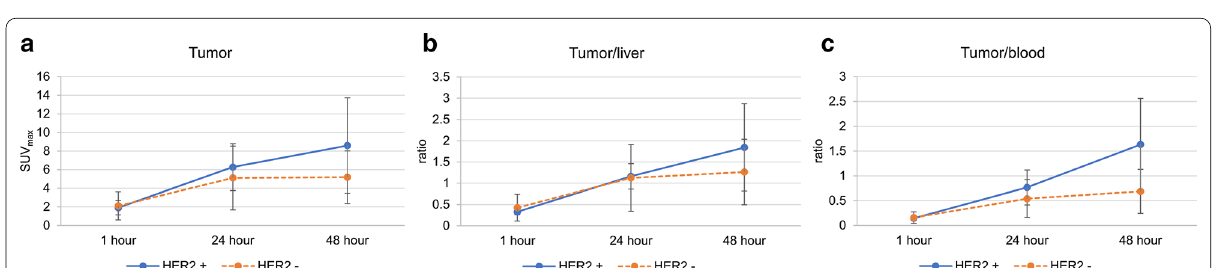
Fig. 4 The changes of SUV max ( a ), tumor‑to‑liver ratio ( b ), and tumor‑to‑blood pool ratio ( c ) of HER2‑positive and HER2‑negative tumors over